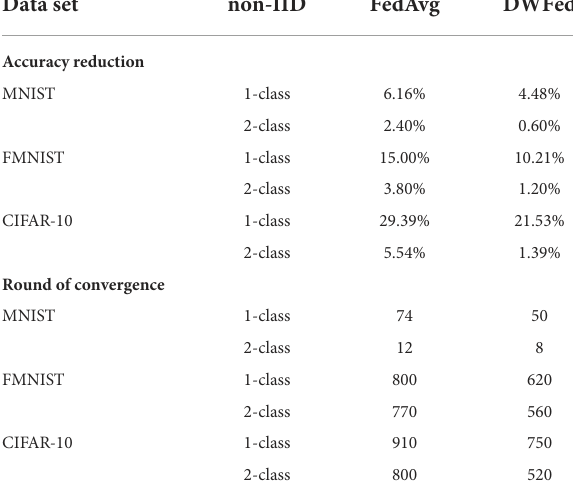
TABLE 2 Performance of FedAvg and